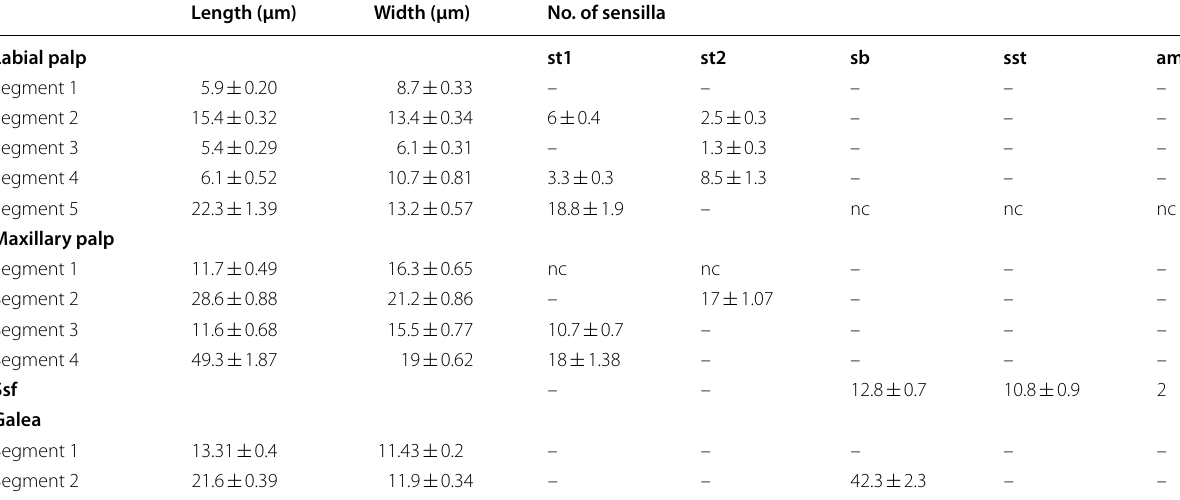
Table 3 Mean (SE) of the length (µm) and width (µm) of the segments of the maxillary and labial papli and galea of maxilla of adult ± Rhyzopertha dominica ( n 5) and the number of their associated sensilla ( n =